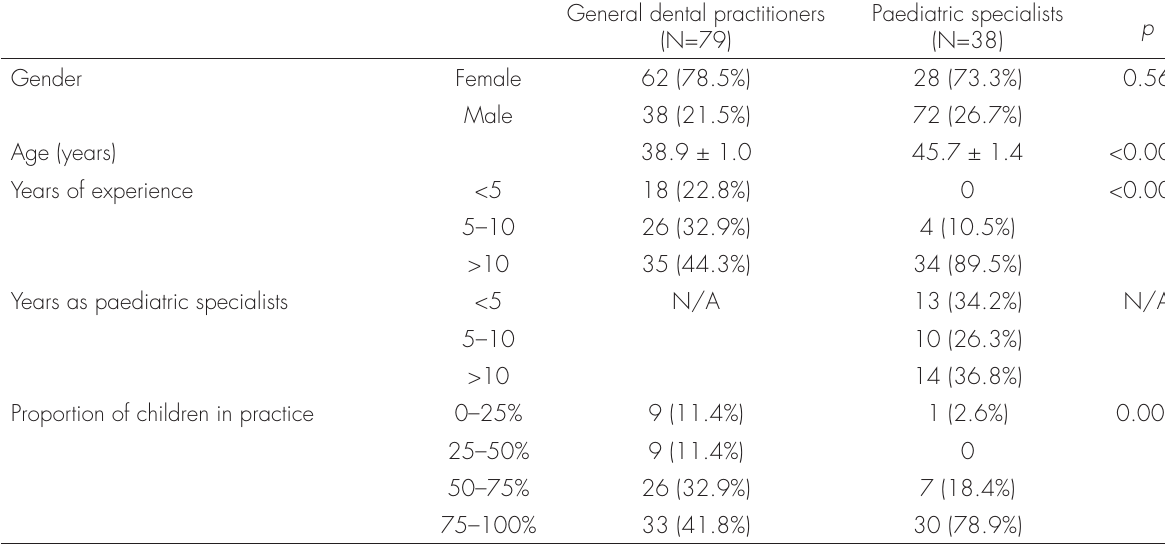
Table I. Biographic details of the participants.